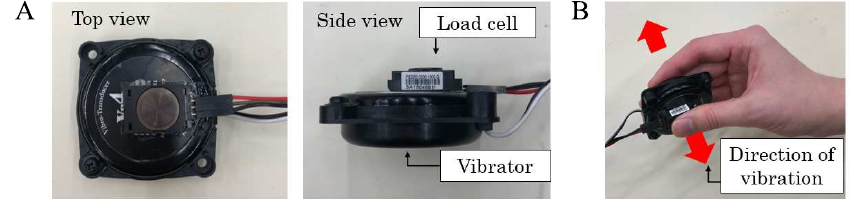
Figure 1. Apparatus. ( A ) Appearance of the apparatus. Load cell is attached to the center of the voice coil motor. ( B ) Direction of vibratory stimuli and how to grip it during the